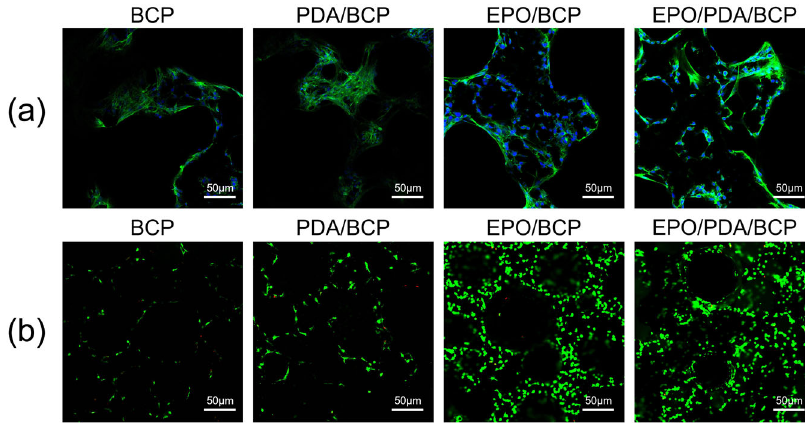
Fig. 4 pDA-induced release of EPO on BCP bioceramics. The EPO/pDA was loaded and the released EPO concentrations at different time points and different pH ( a : pH = 6; b : pH = 7; c : pH = 8) were quanti fi ed using ELISA. (** p < 0.01, * p < 0.05)